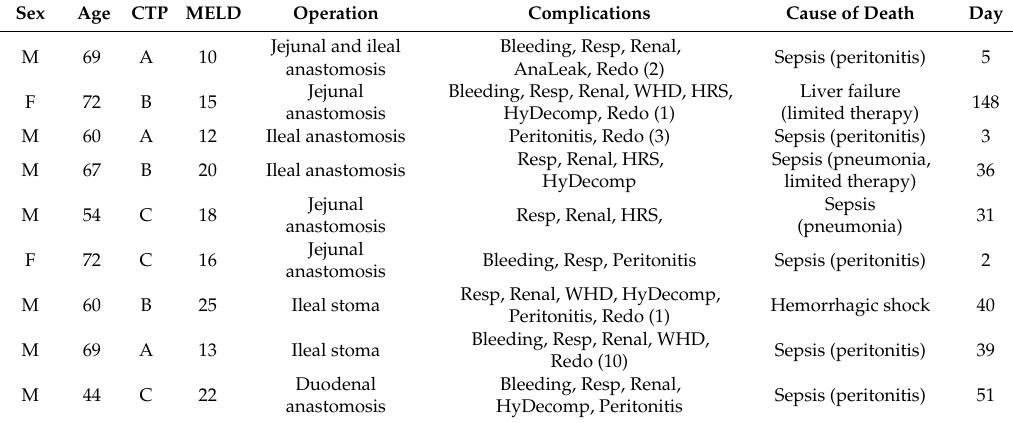
Table 3. Mortality cases.